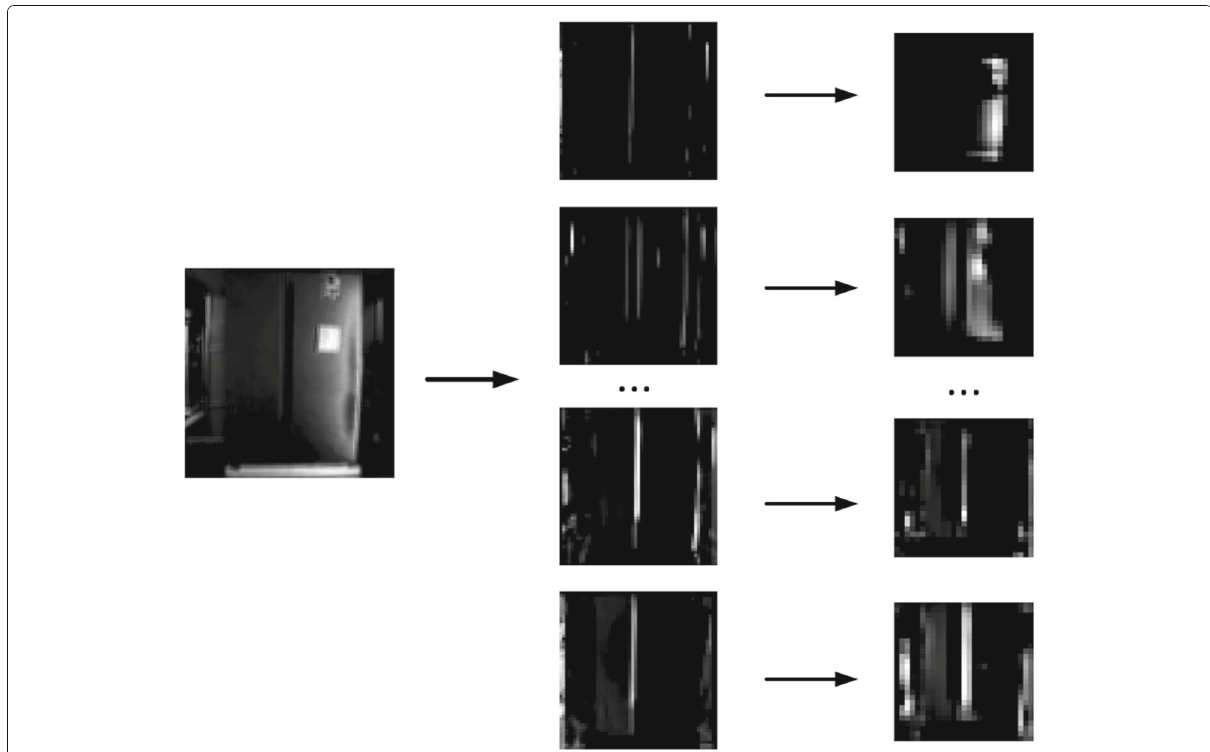
Fig. 7 The feature maps extracted hierarchically by our proposed CNN architecture